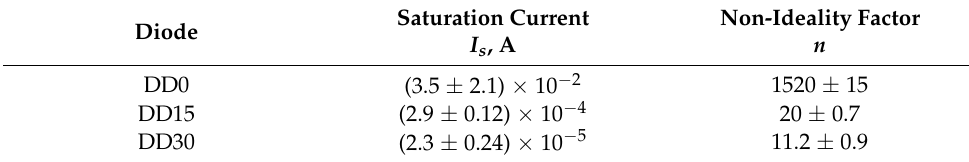
Table 5. Fitting parameters of the IV characteristics approximated with Equation (3). Saturation Diode